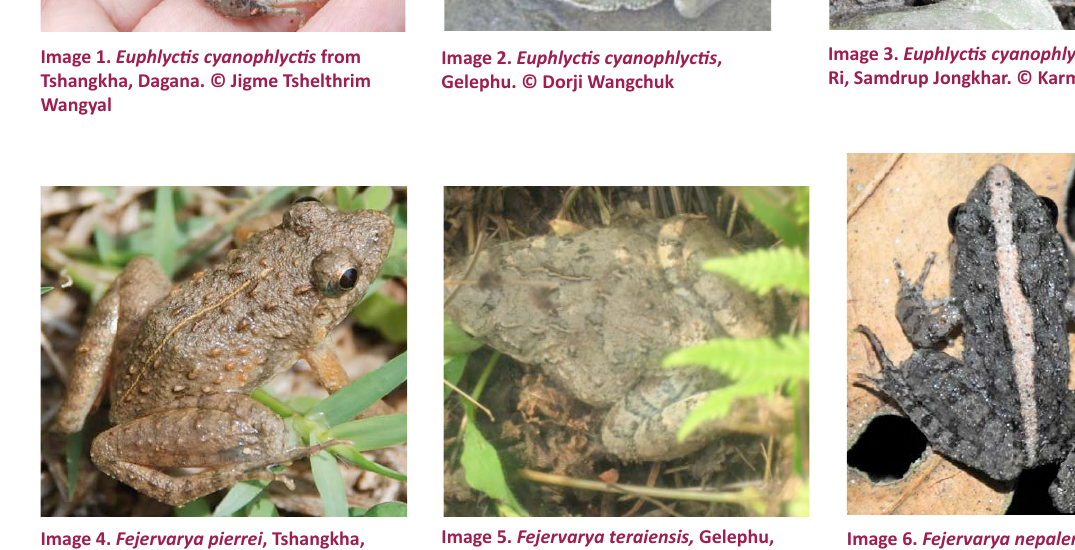
Image 6. Fejervarya nepalensis , Ngera Ama Ri, Samdrup Jongkhar. © Karma